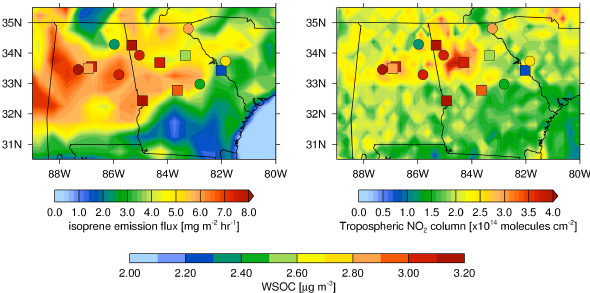
Fig. 6. Spatial distributions of (a) isoprene emission fluxes (0.5 ◦ ×0.5 ◦ ) predicted from MEGAN-ECWMF global inventory and (b) tropospheric NO 2 column density from OMI on board NASA AURA satellite in August of 2007. Overlaid on the emis- sion maps are the color-coded WSOC NB concentrations at the 15 FRM sampling sites (urban: squares; rural: circles) in August 2007 (Note that the WSOC NB color scale is set to investigate relatively small changes in absolute WSOC NB